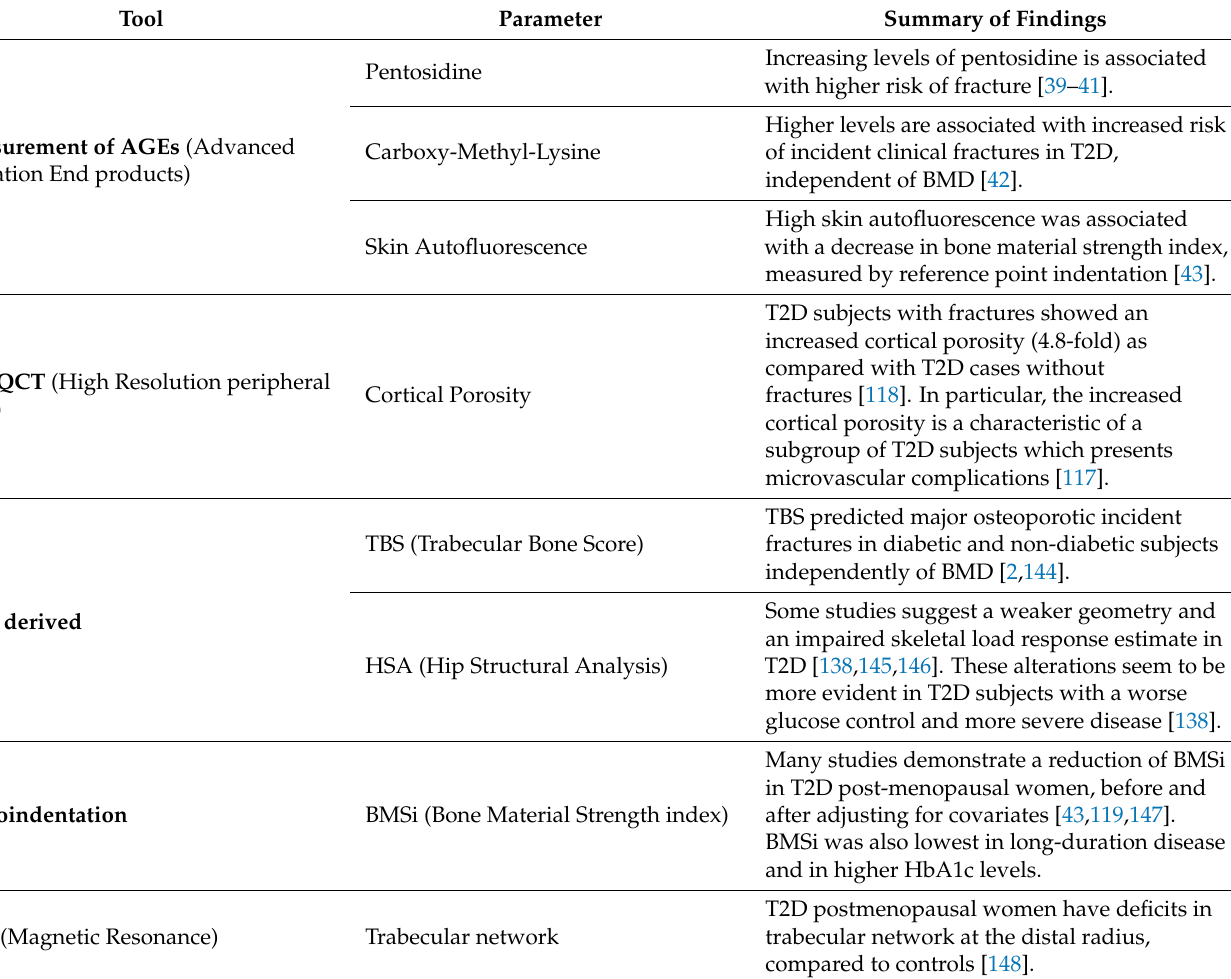
Table 1. Studies that analyzed additional diagnostic tools for the prediction of fracture risk in type 2